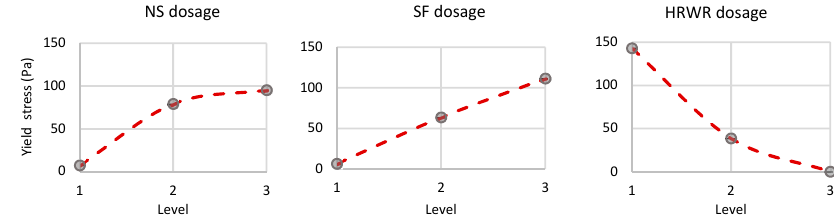
Figure 6. Influence of factors on yield stress values.